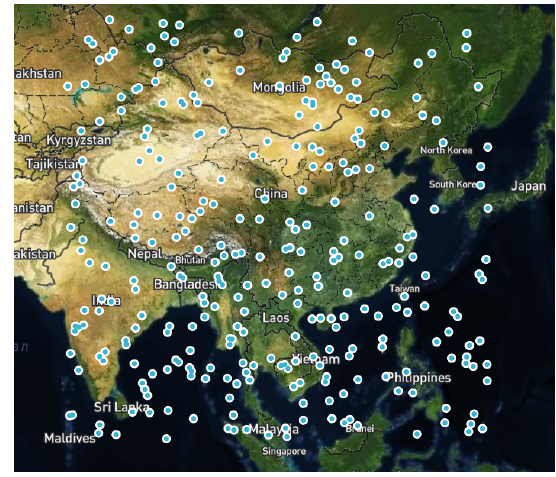
Figure 1. An example for the benchmark instances of area